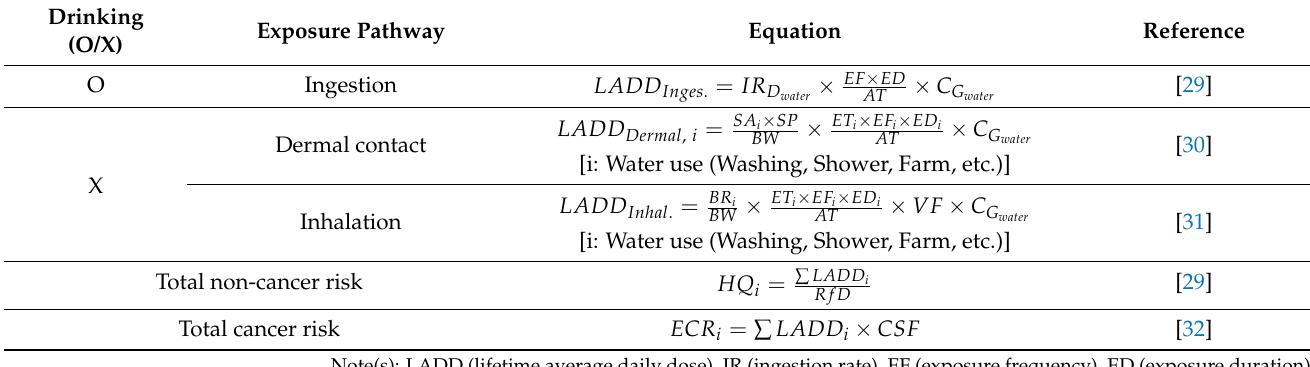
Table 4. Risk assessment formula considering ingestion, dermal contact, and